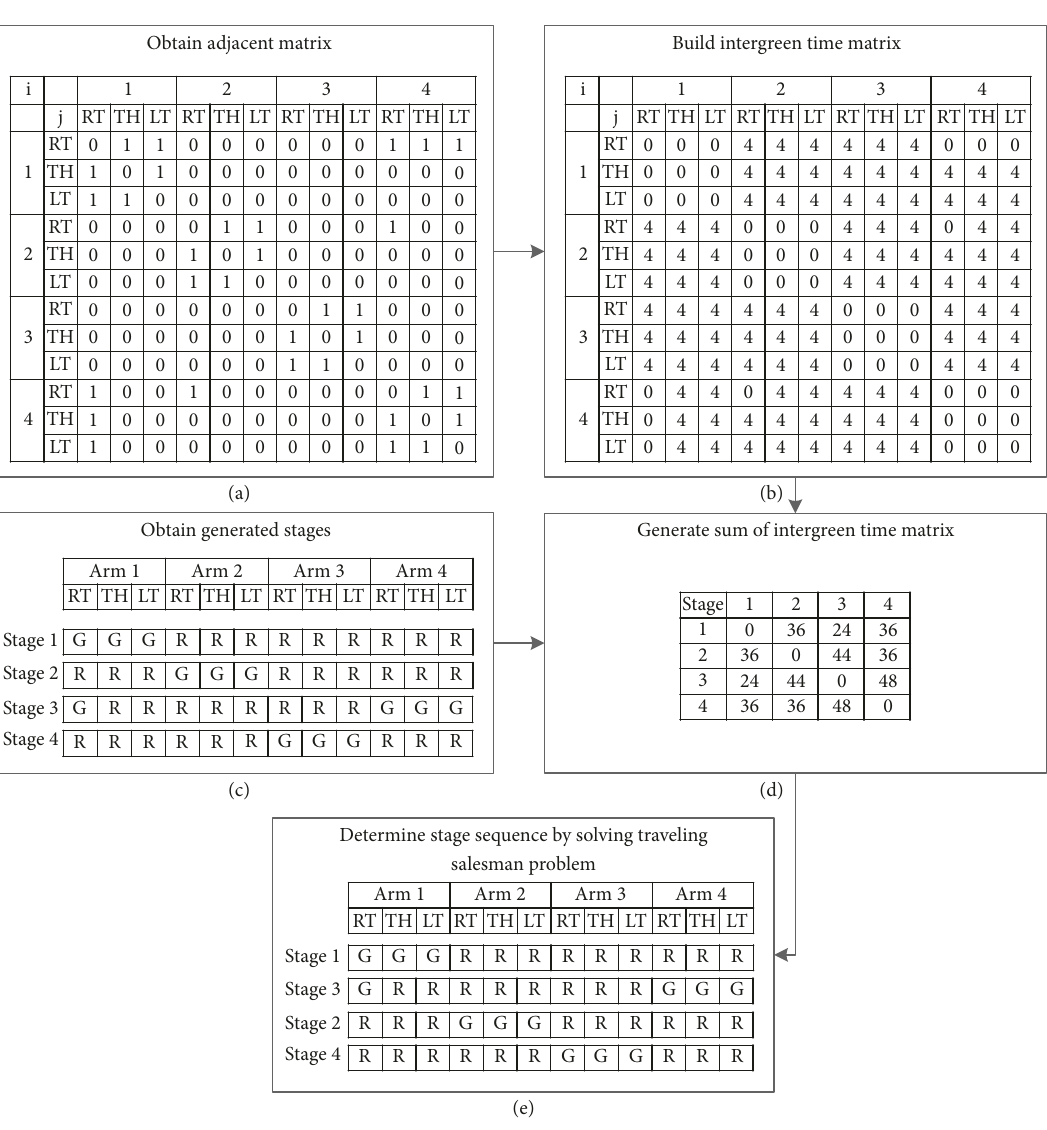
Figure 4: An example of stage sequence optimization: (a) obtaining adjacent matrix; (b) building intergreen time matrix; (c) obtaining generated stages; (d) generating sum of intergreen time matrix; (e) determining stage sequence by solving traveling salesman